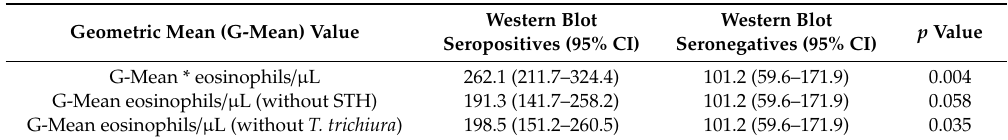
Table 4. Mann–Whitney U test results comparing geometric mean of circulating eosinophil levels in seropositive vs. seronegative schoolchildren ( n = 73) †